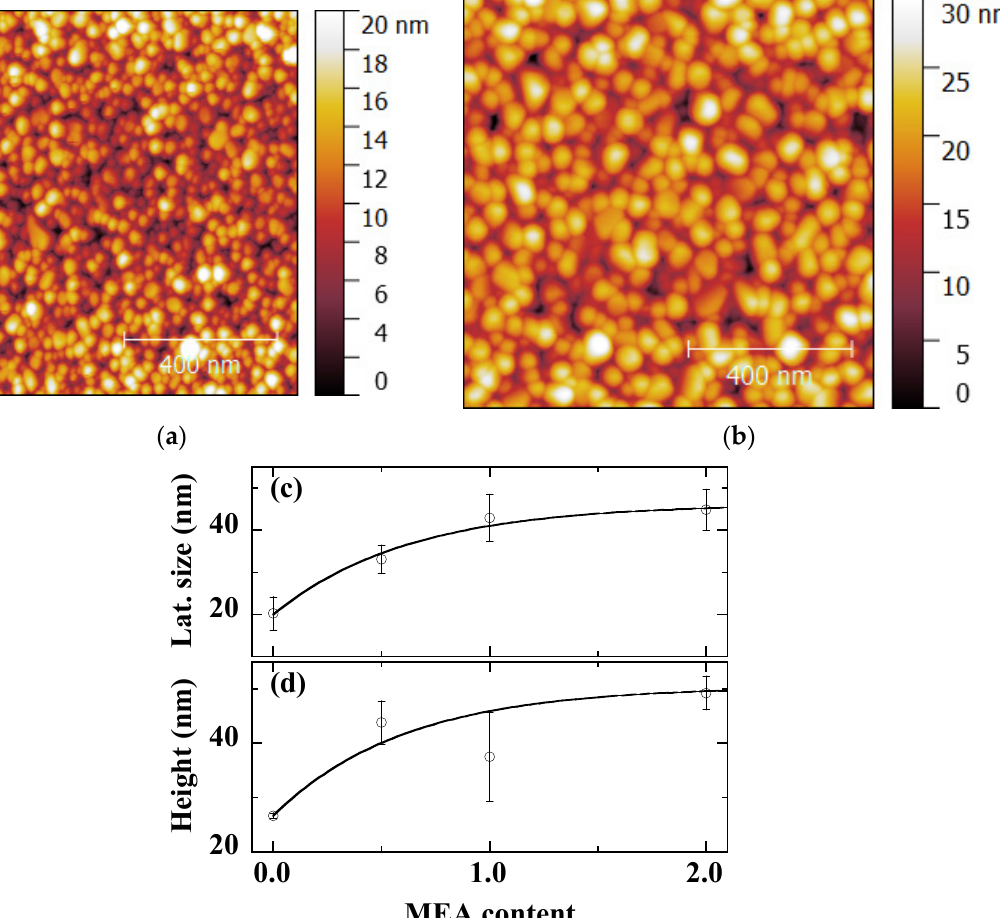
Figure 8. 1 µ m × 1 µ m AFM micrographs of sol-gel spin-coated ZnO samples obtained with MEA contents r = 0 ( a ) and r = 1.0 (standard conditions) ( b ). AFM lateral size ( c ) and height ( d ) of sol-gel spin-coated ZnO samples obtained with various MEA contents. The curves are provided as guides for the eye.